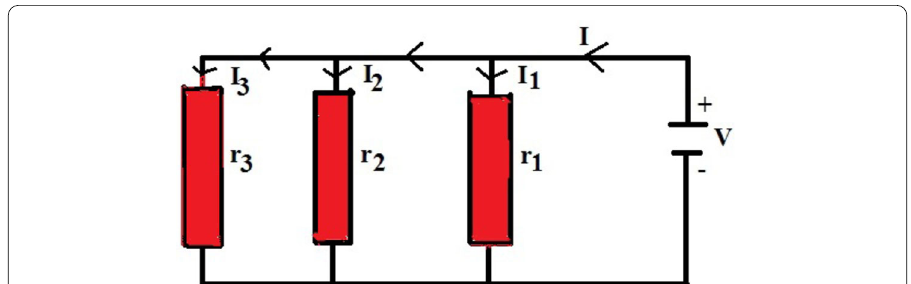
Figure 6 Parallel circuit with three resistances